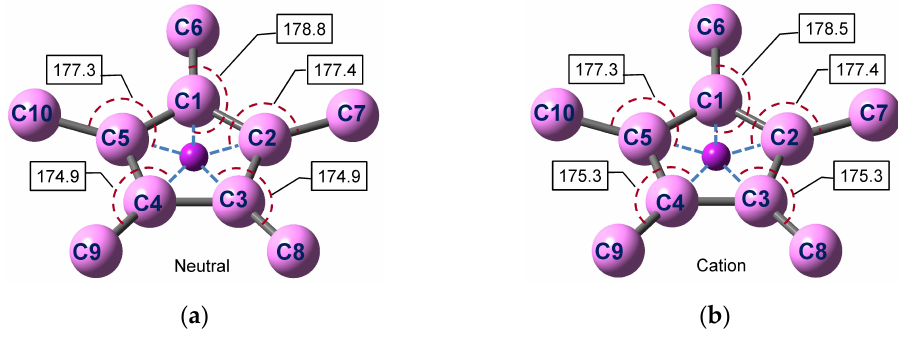
Figure 6. Centroid(ring)-C(ring)-C(Me) angles in the optimized Cp* 2 Mn 0 neutral ( a ) and Cp* 2 Mn + cation ( b ). The hydrogen atoms are omitted for clarity.